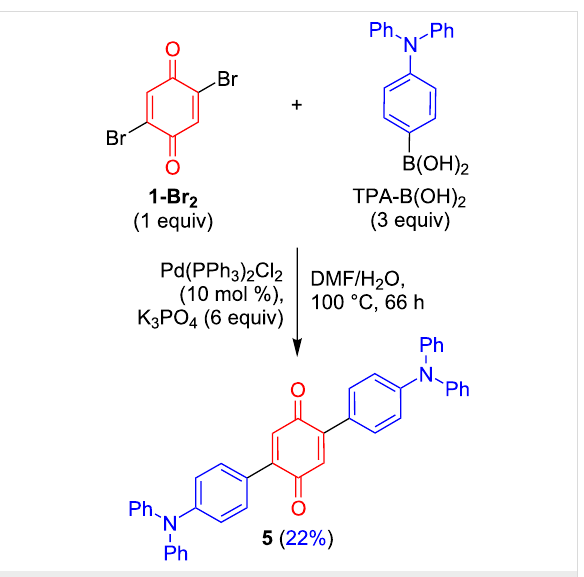
temperature of 30 °C and longer reaction time (48 h) were re-